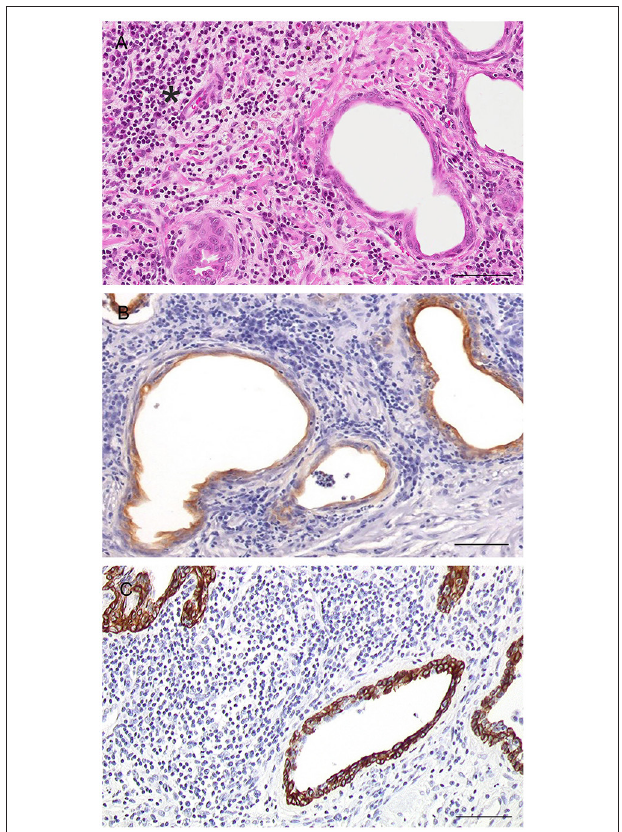
FIGURE 9 | Histological and immunohistochemical features of glandular atrophy associated with chronic inflammation (PIA-like lesions). (A) Gland with attenuated epithelium and surrounding chronic inflammatory infiltrate (asterisk). Hematoxylin-eosin staining. Bar = 120 µ m. (B) Cytoplasmic expression of CK8/18 by epithelial cells of the PIA-like lesions. IHC. DAB chromagen. Meyer’s hematoxylin counterstain. Bar = 120 µ m (mouse monoclonal anti-human Ck8/18, Novocastra, 1:600). (C) Cytoplasmic expression of CK5 by epithelial cells of the PIA-like lesions. IHC. DA chromagen. Meyer’s hematoxylin counterstain. Bar = 120 µ m (mouse monoclonal anti-human CK5, Novocastra,